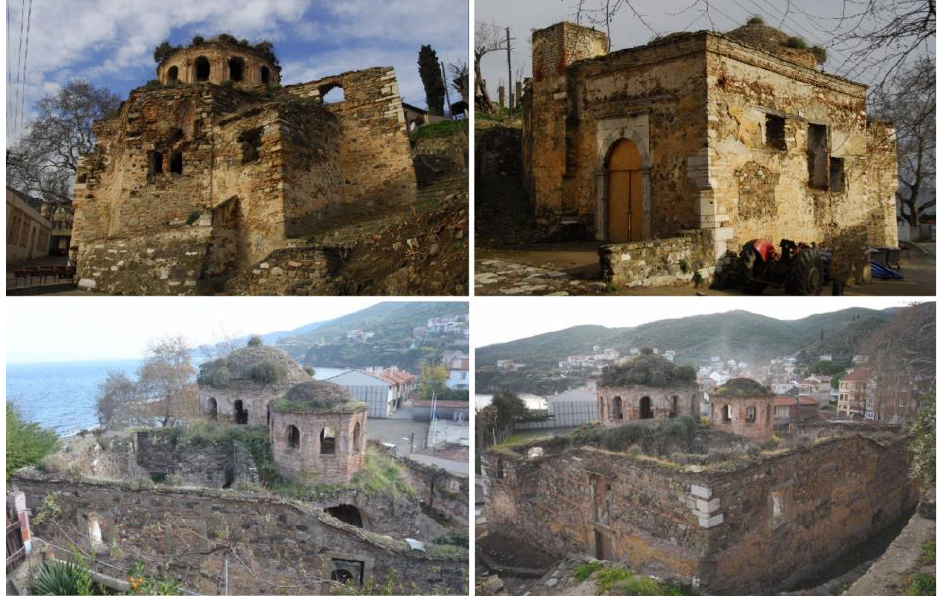
Figure 4. Exterior views of the structure [32].